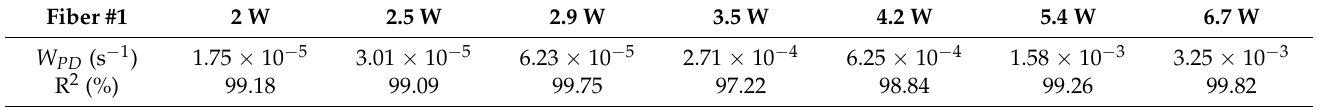
Table 1. Calculated PD rates under different pump powers of Fiber #1.